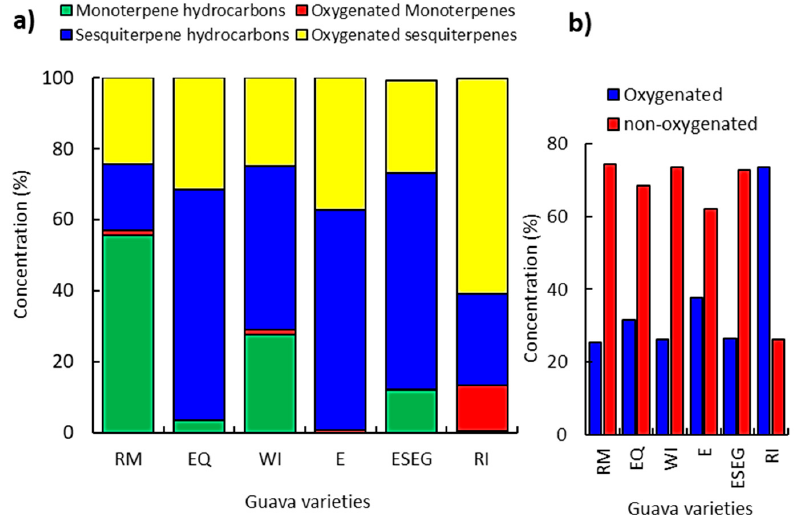
Figure 2. Relative percentile levels of the different classes of the identified compounds of the six studied varieties of P. guajava ; ( a ) the four specified classes, and ( b ) the oxygenated and non-oxy- genated components.